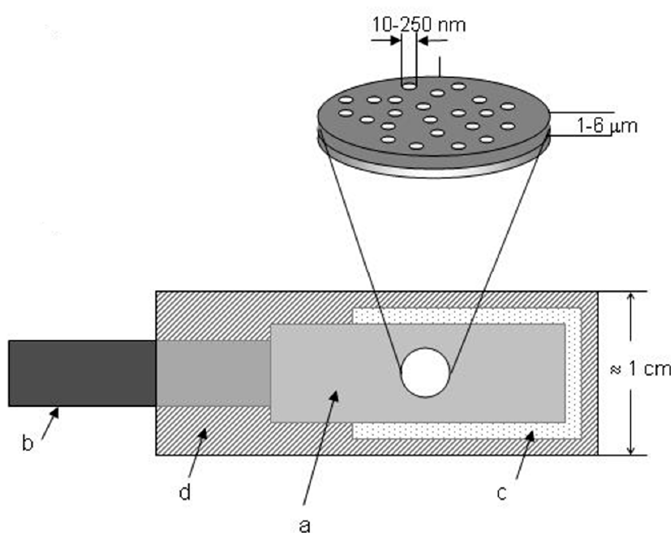
Figure 4. Schematic representation of a NEE, prepared by using a track-etched polycarbonate membrane as template: ( a ) track-etched golden membrane; ( b ) copper adhesive tape with conductive glue to connect to instrumentation; ( c ) aluminium adhesive foil with nonconductive glue; ( d ) thermoadhesive insulating tape (e.g., Monokote by Topflite). Note: the dimensions of the pores (nanofibres) are only indicative and not to scale (reprinted with permission from [52]).